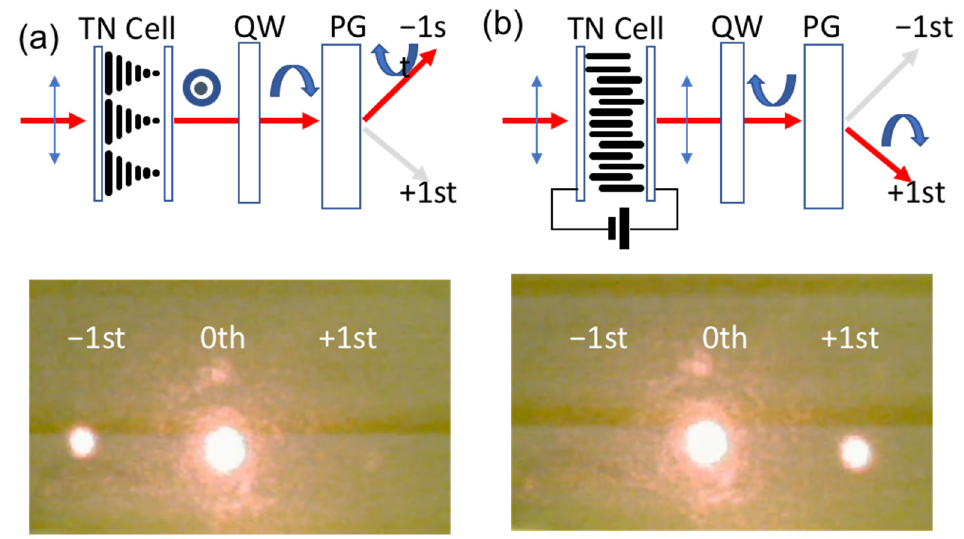
Figure 6. Schematic diagram ( top ) and photograph of diffraction ( bottom ) of proposed optical switch based on PG at ( a ) voltage-off state and ( b ) voltage-on state.